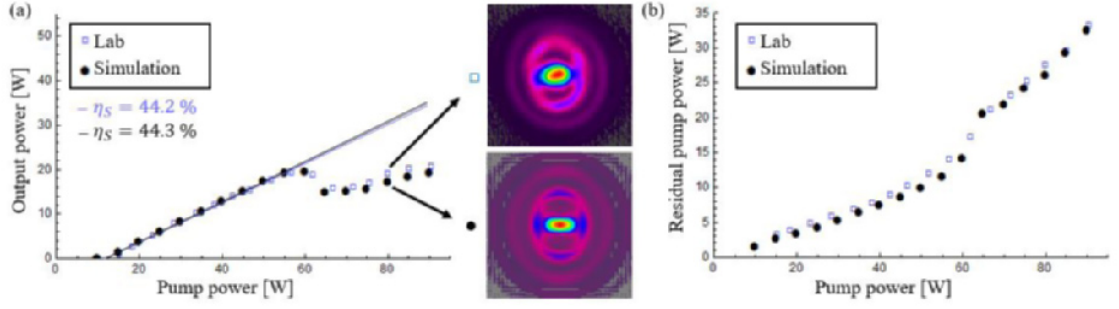
Figure 1. Comparison of an experimental Ho 3+ :YAG resonator setup with the model. In (a), the laser output power is compared, in (b) the residual pump